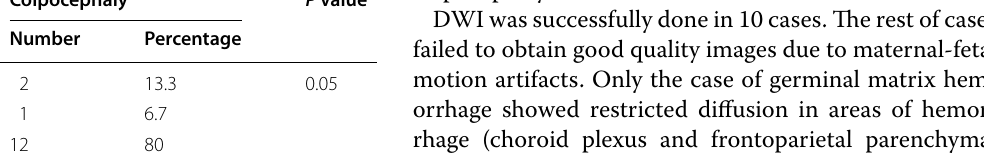
Table 5 Relation between severity of ventriculomegaly and presence or absence of colpocephaly